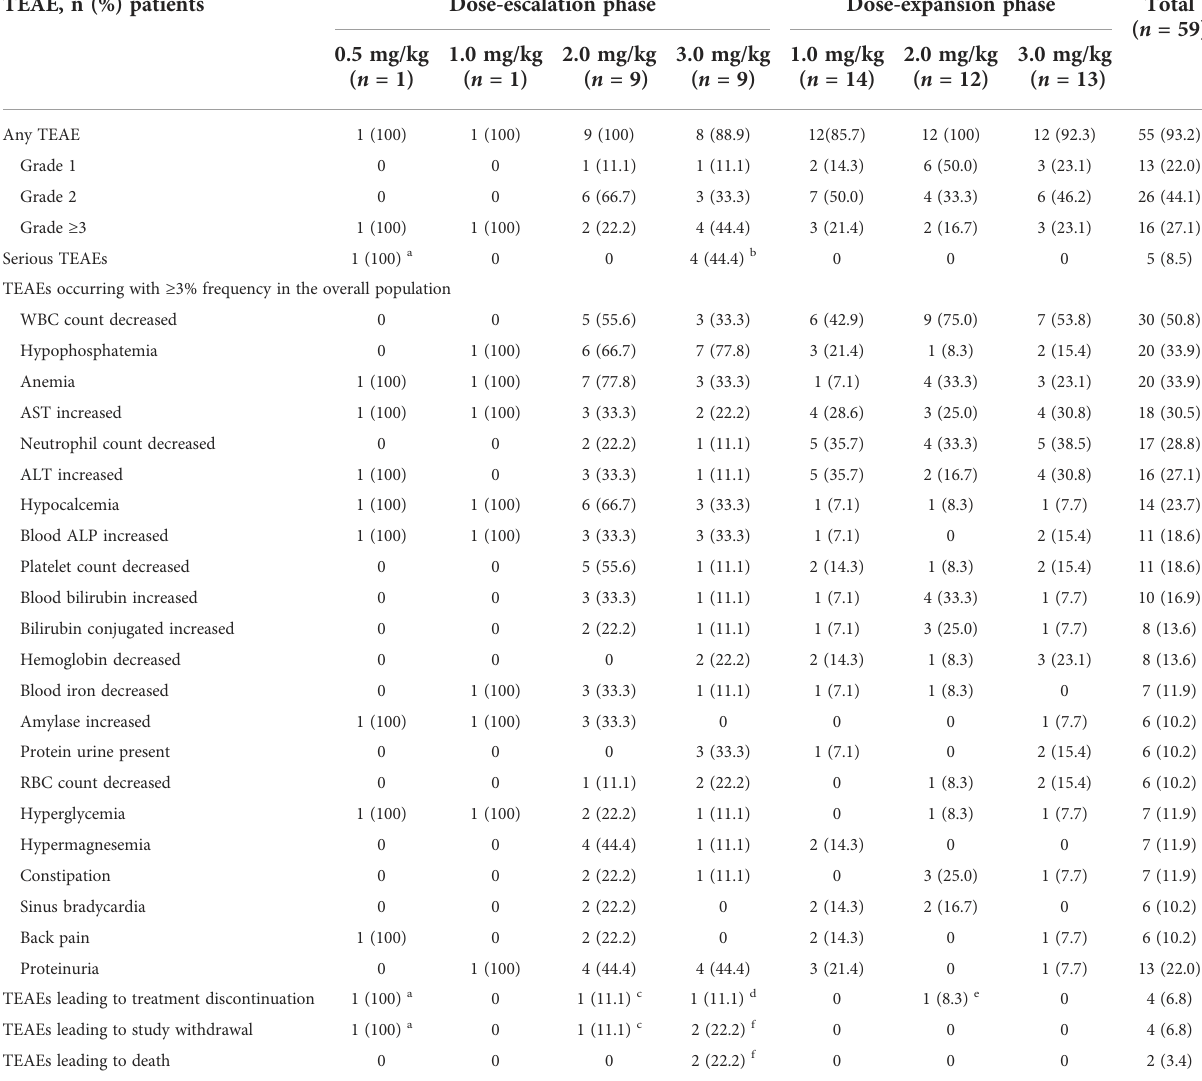
TABLE 2 Summary of treatment-emergent adverse events of JMT103 in the SAS. TEAE, n (%)